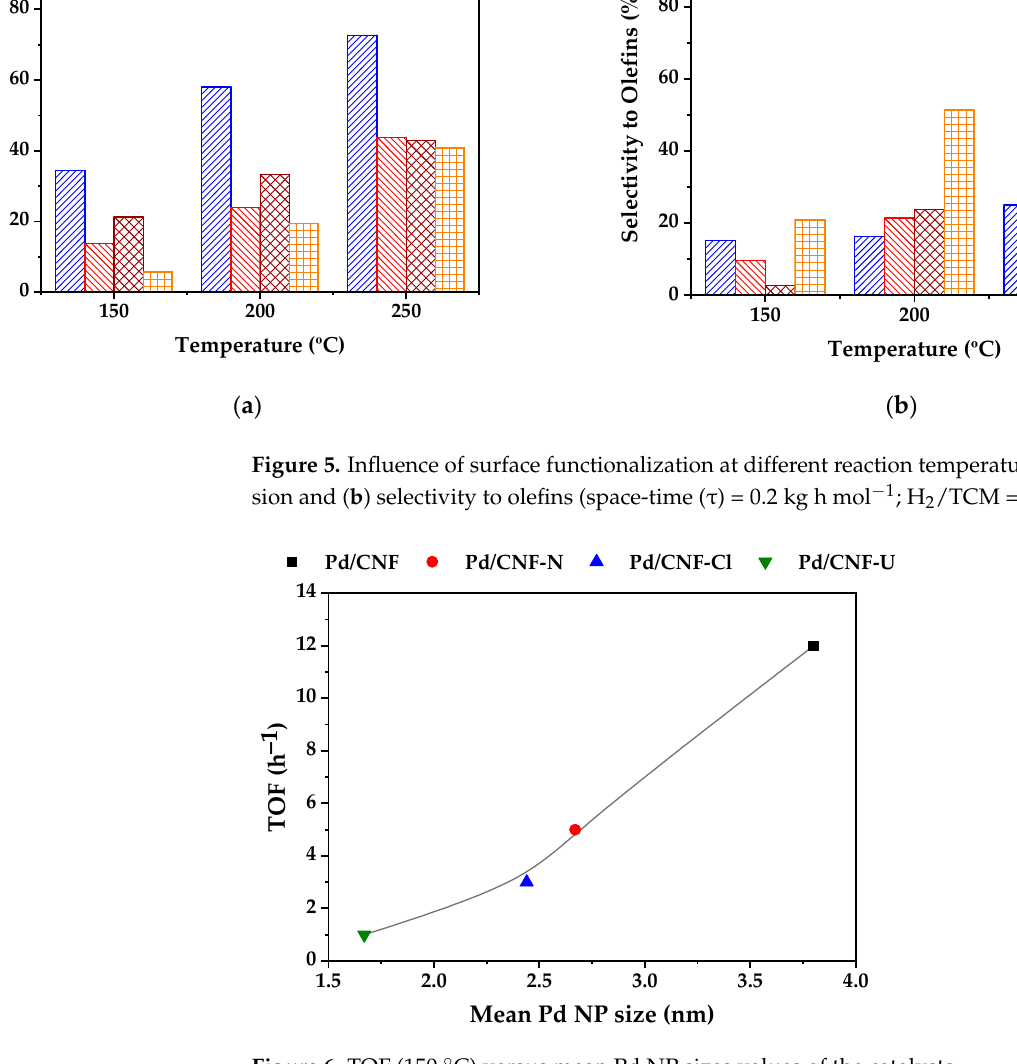
Figure 6. TOF (150 °C) versus mean Pd NP sizes values of the catalysts. Figure 6. TOF (150 ◦ C) versus mean Pd NP sizes values of the